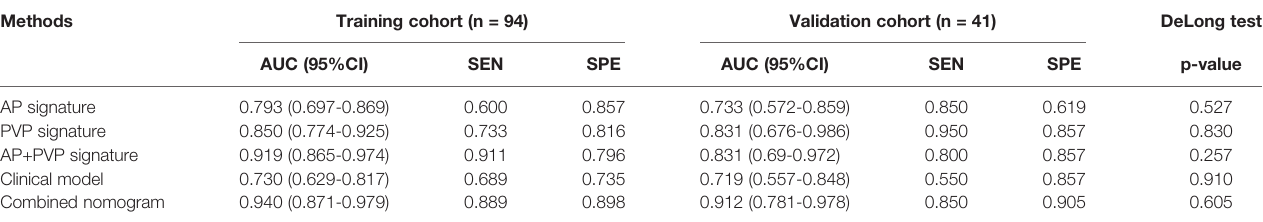
TABLE 2 | Performance of the radiomics signatures, clinical model, and combined nomogram model.